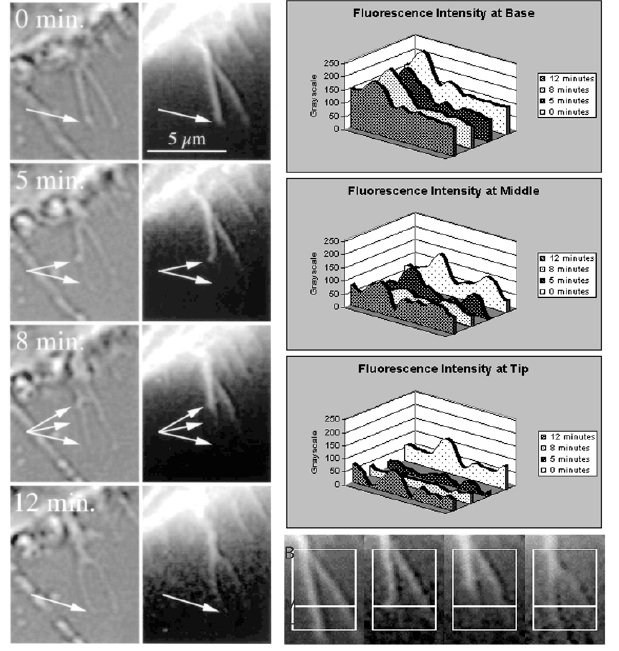
Figure 5 DIC and fluorescence time-lapse imaging of microextensions in live C-moesin-GFP transfected cells. C-moesin-GFP fluo- rescence is seen to withdraw from and to re-enter an attached microextension (arrows). Note that the fluores- cence intensities of C-moesin-GFP in two closely spaced microextensions, and hence their actin filament contents, are independent of each other. This is illustrated on the right side of the figure by showing intensity distributions at three different points (indicated by lines B (for Base), M (for mid- dle) and T (for Tip) in the four panel at the very bottom) along the two filopodia. See also three related movie files (Additional Material).